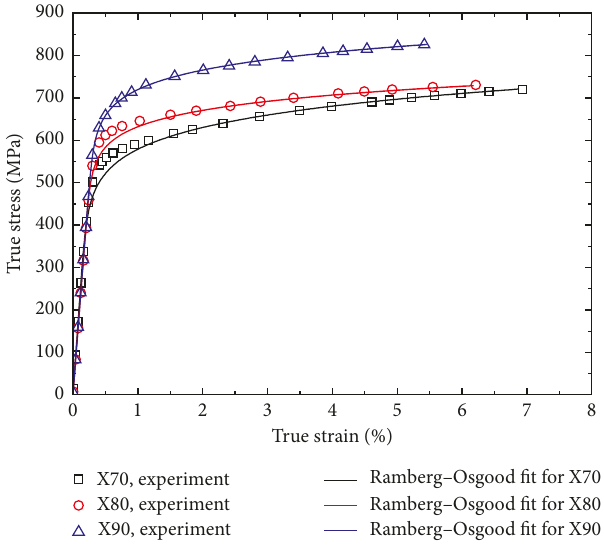
Figure 9: True stress-strain curves for pipeline steels. Table 5: Tensile properties of pipeline steels at room temperature in the FE analysis.